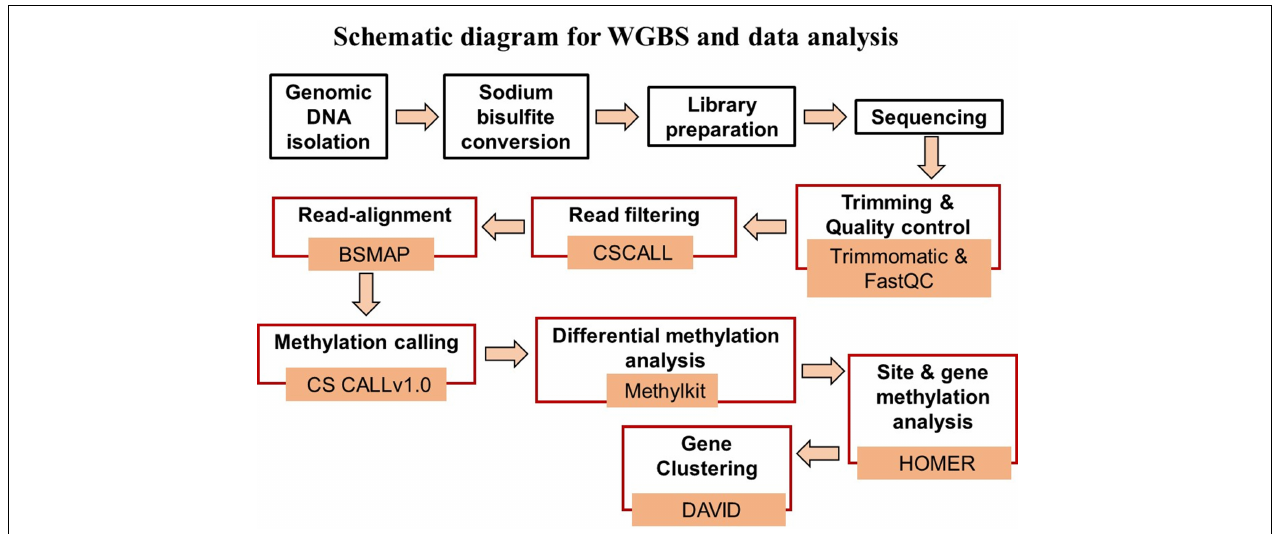
FIGURE 1 | Schematic diagram of the steps for WGBS (black boxes) and data analysis (red boxes), and associated data analysis